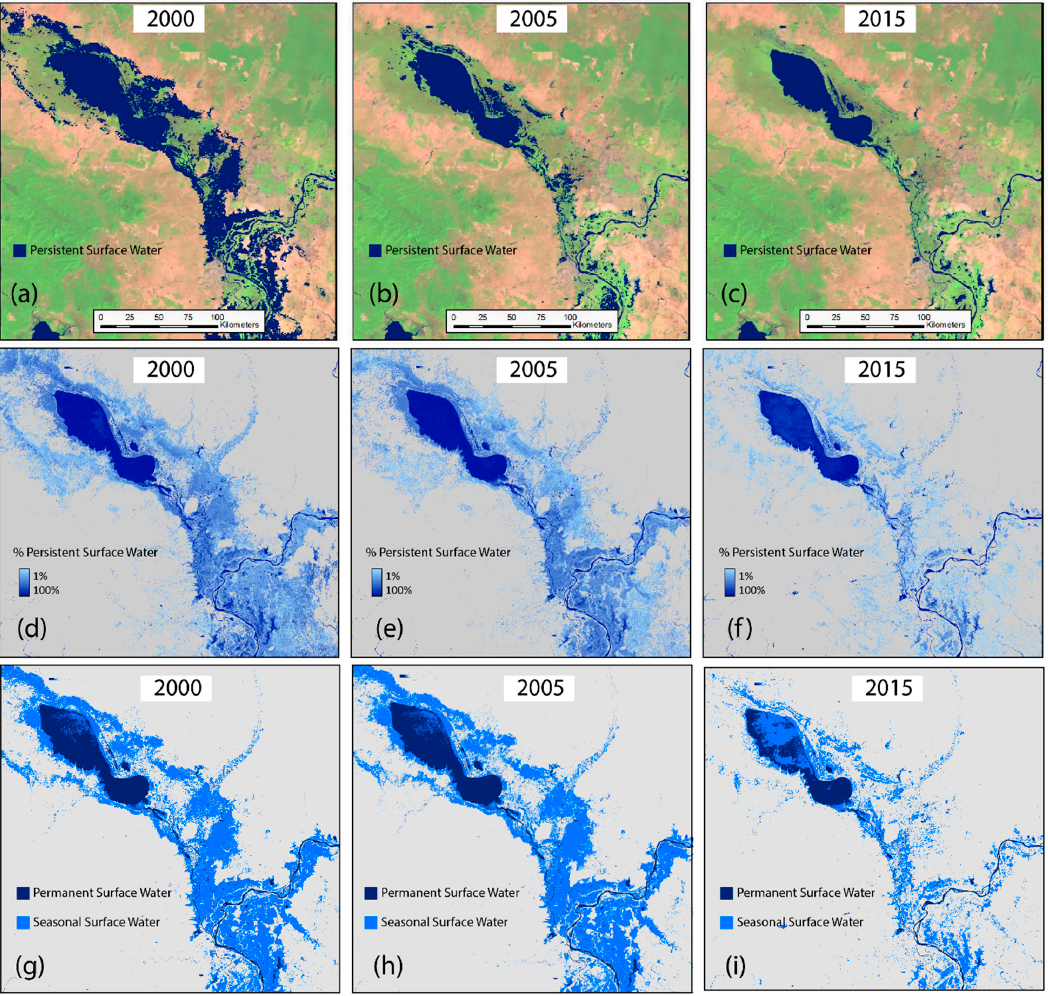
Figure 3. Annual persistent surface water extent for the Tonle Sap Lake and Lower Mekong River in Cambodia from MOD44W C6.0 (data overlain in dark blue) for ( a ) 2000, ( b ) 2005, and ( c ) 2015. Annual persistent water using a threshold definition between 1% to 100% surface water extent for Tonle Sap Lake and Lower Mekong River in Cambodia from GLAD for ( d ) 2000, ( e ) 2005, and ( f ) 2015. Annual permanent (dark blue) and seasonal (light blue) surface water extent for Tonle Sap Lake and Lower Mekong River in Cambodia from Global Surface Water Explorer (GSWE) for ( g ) 2000, ( h ) 2005, and ( i ) 2015.